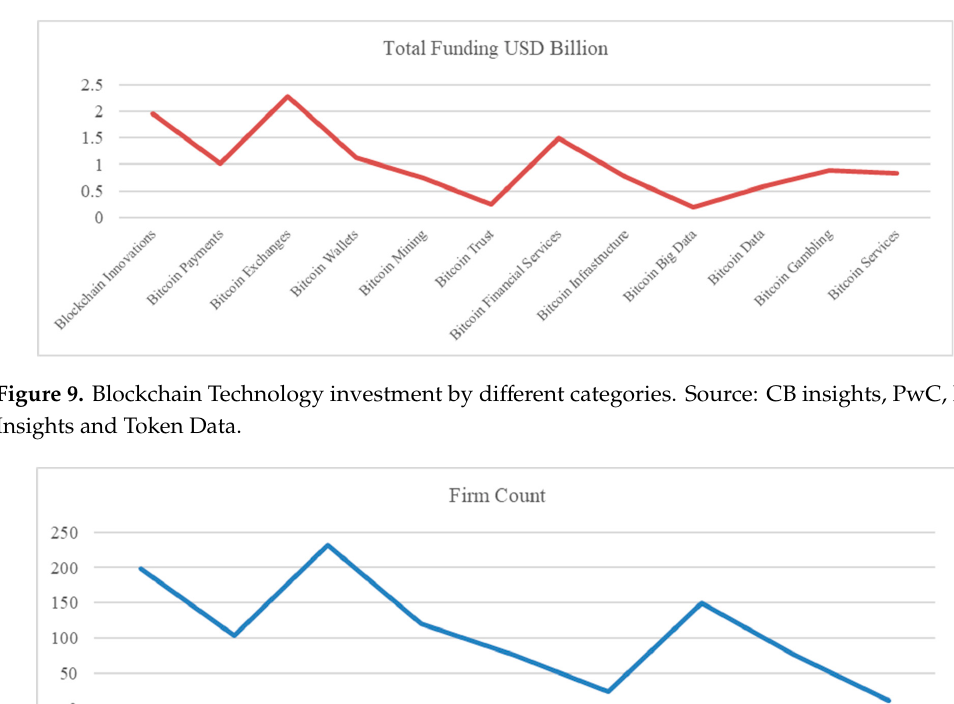
Figure 8. Percentage of Blockchain and related start-ups by geography between 2017 and end of February 2018. Source: CB insights, PwC, ICO Insights and Token Data.